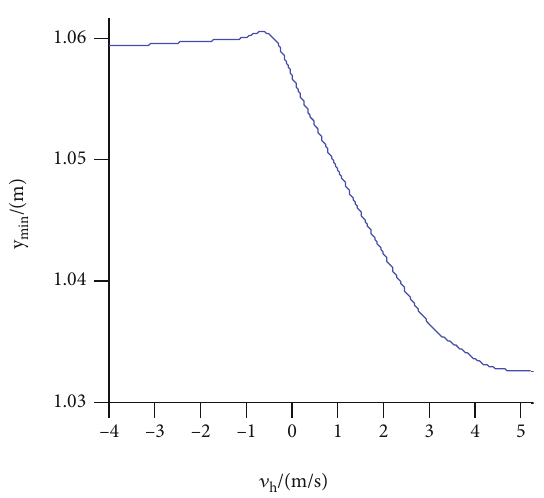
Figure 3: Minimum displacement curve of the body from the lunar